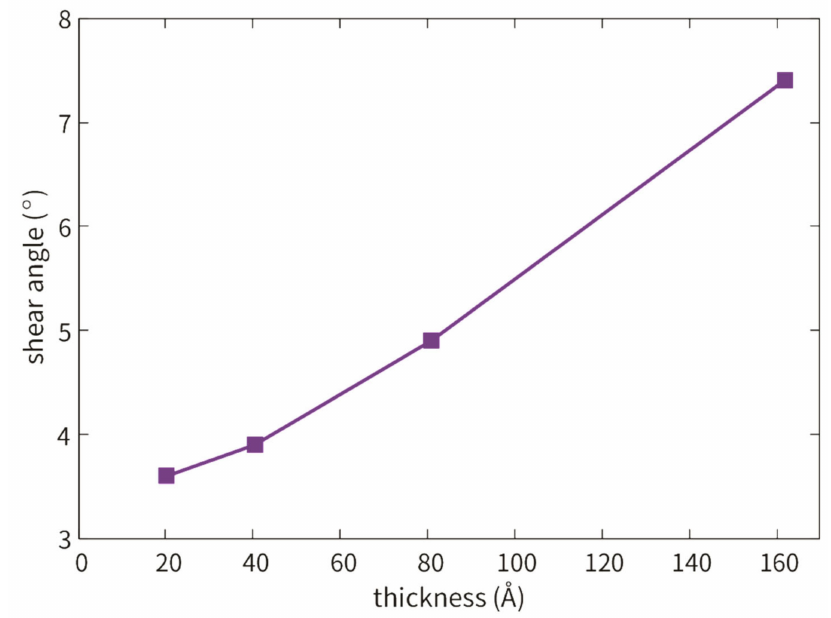
Figure 14. Dependence of shear angle, for which a fraction of 50% has been transformed from fcc to bcc, on film